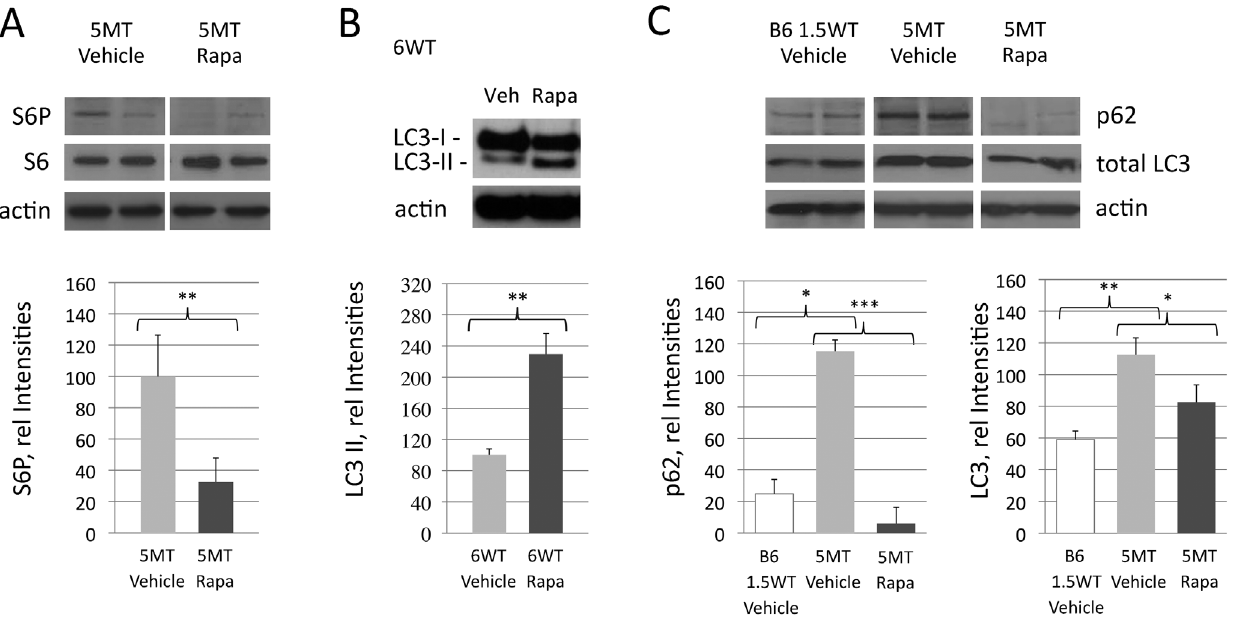
Figure 4. Consistent with cerebral mTOR inhibition, phosphorylation of S6 (S6P) was significantly reduced following rapamycin administration (A, 5MT group, n=4/4). Compatible with an induced autophagy pathway, LC3II levels were increased upon rapamycin treatment (B, 6WT group, n=6/6). High levels of the autophagy associated proteins p62 and LC3 were measured in aged vehicle treated P301S transgenic mice (C; 5MT Vehicle, n=4). This accumulation of p62 and LC3 was prevented by long-term rapamycin administration, pointing towards a restored autophagic flux (C; 5MT Rapa, n=4). Forebrain tissue was used and data was analyzed by ANOVA. * p , 0.05, ** p , 0.01, and *** p , 0.001.